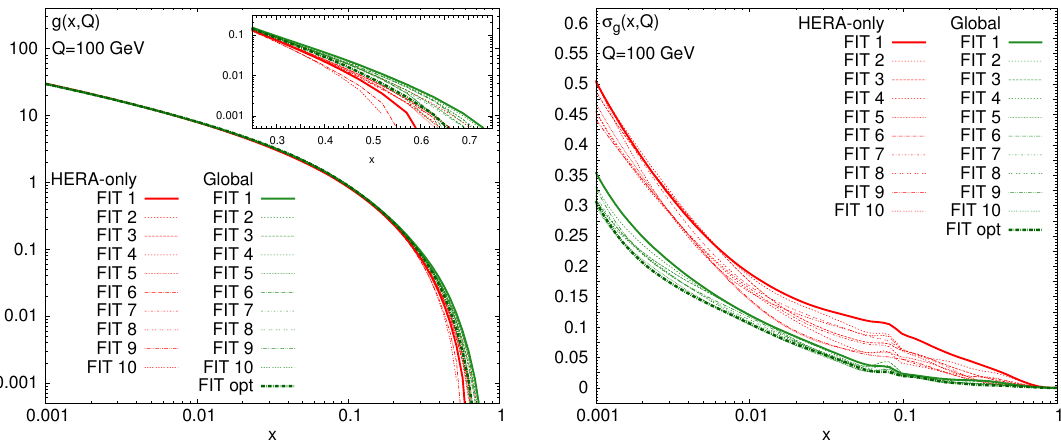
Figure 15 . The central value (left) and the one-sigma uncertainty (right) of the gluon PDF at Q = 100 GeV for all the HERA-only and the global (cid:12)ts, including our optimal (cid:12)t to the optimal combination of top-quark pair di(cid:11)erential distributions (FIT opt), collected in tables 6{7. The inset in the left plot focuses on the gluon central values in the large- x